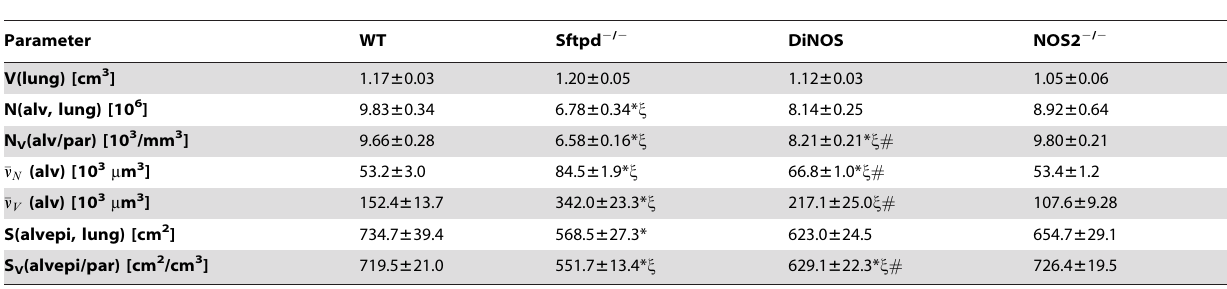
Table 1. Stereological data of lung architecture.